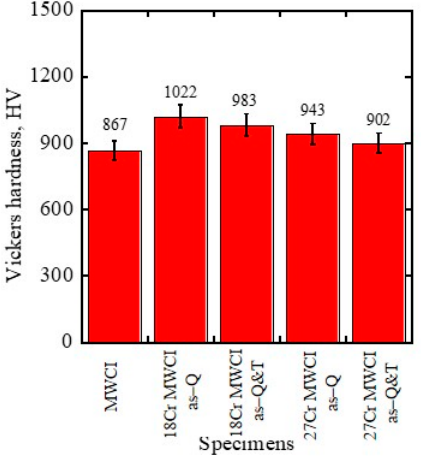
Figure 7. Vickers hardness of each material.